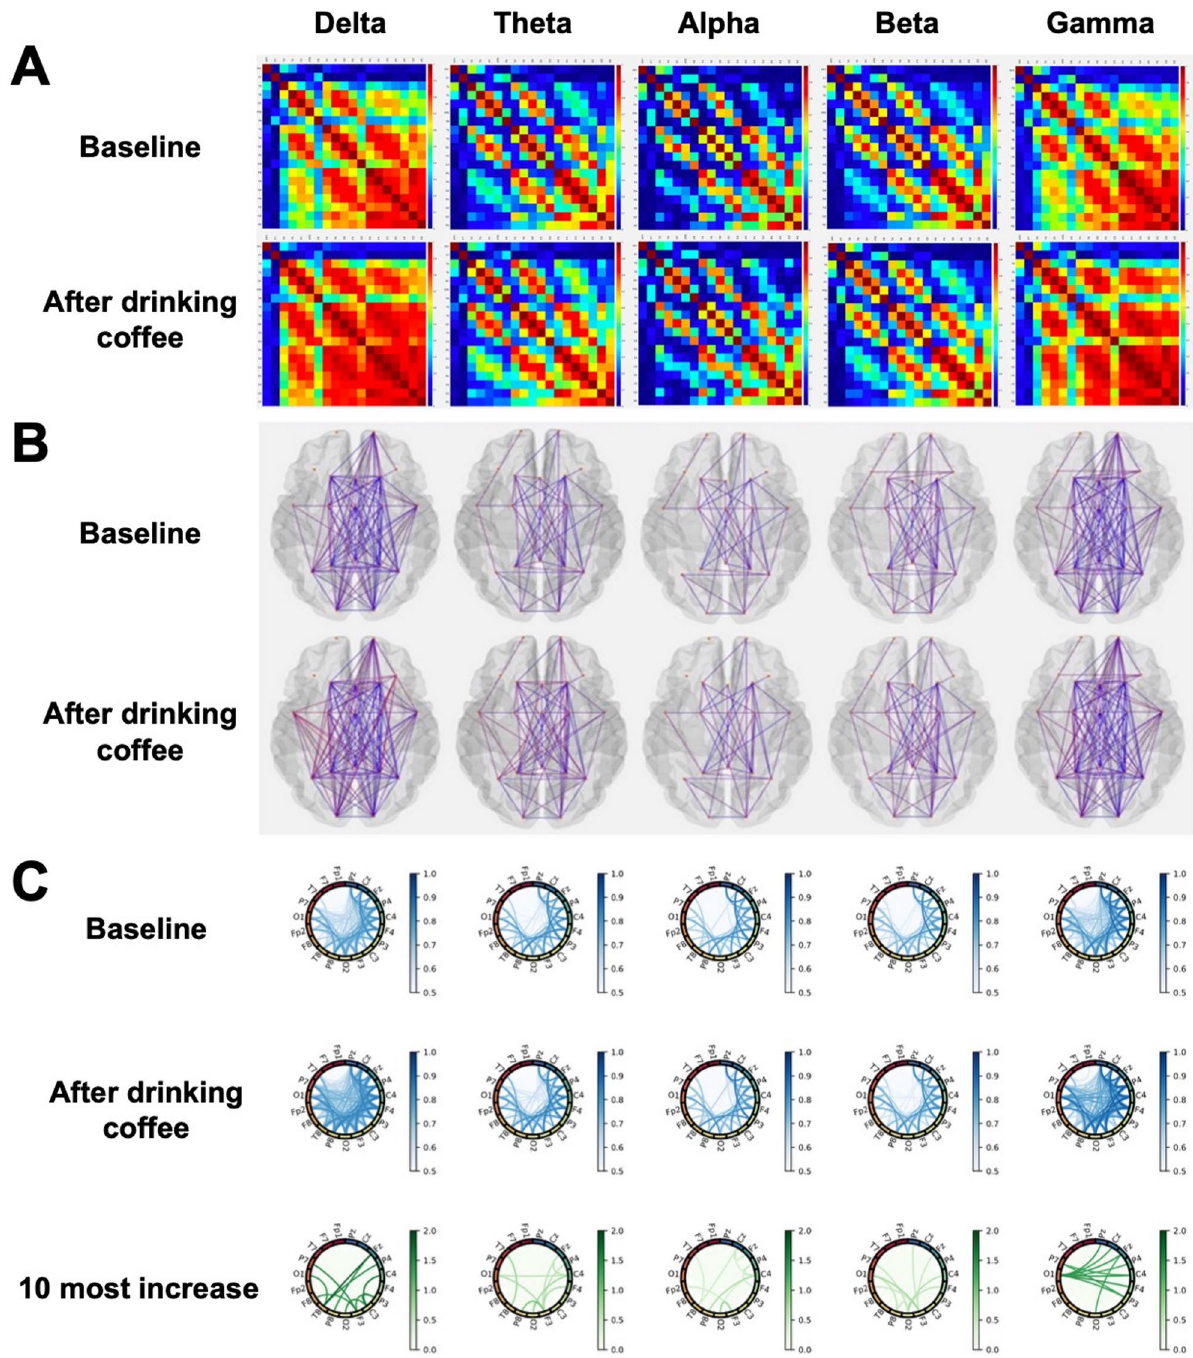
Figure 3. Coherence averaged across all subjects. ( A ) The plots show the coherence between 19 pairs of scalp electroencephalography electrodes in each frequency band at baseline (upper) and after coffee consumption (low). ( B ) Brain topologies of functional connectivity at baseline (upper) and after coffee consumption (low) are presented. ( C ) Each column corresponds to a frequency band as indicated on the top of the figure. Coherence matrices corresponding to the resting-state EEG before and after coffee consumption are plotted on the first and second rows, respectively; to avoid confusion from too many lines, those of coherence less than 0.5 are not shown. The third row displays the top 10 most increased